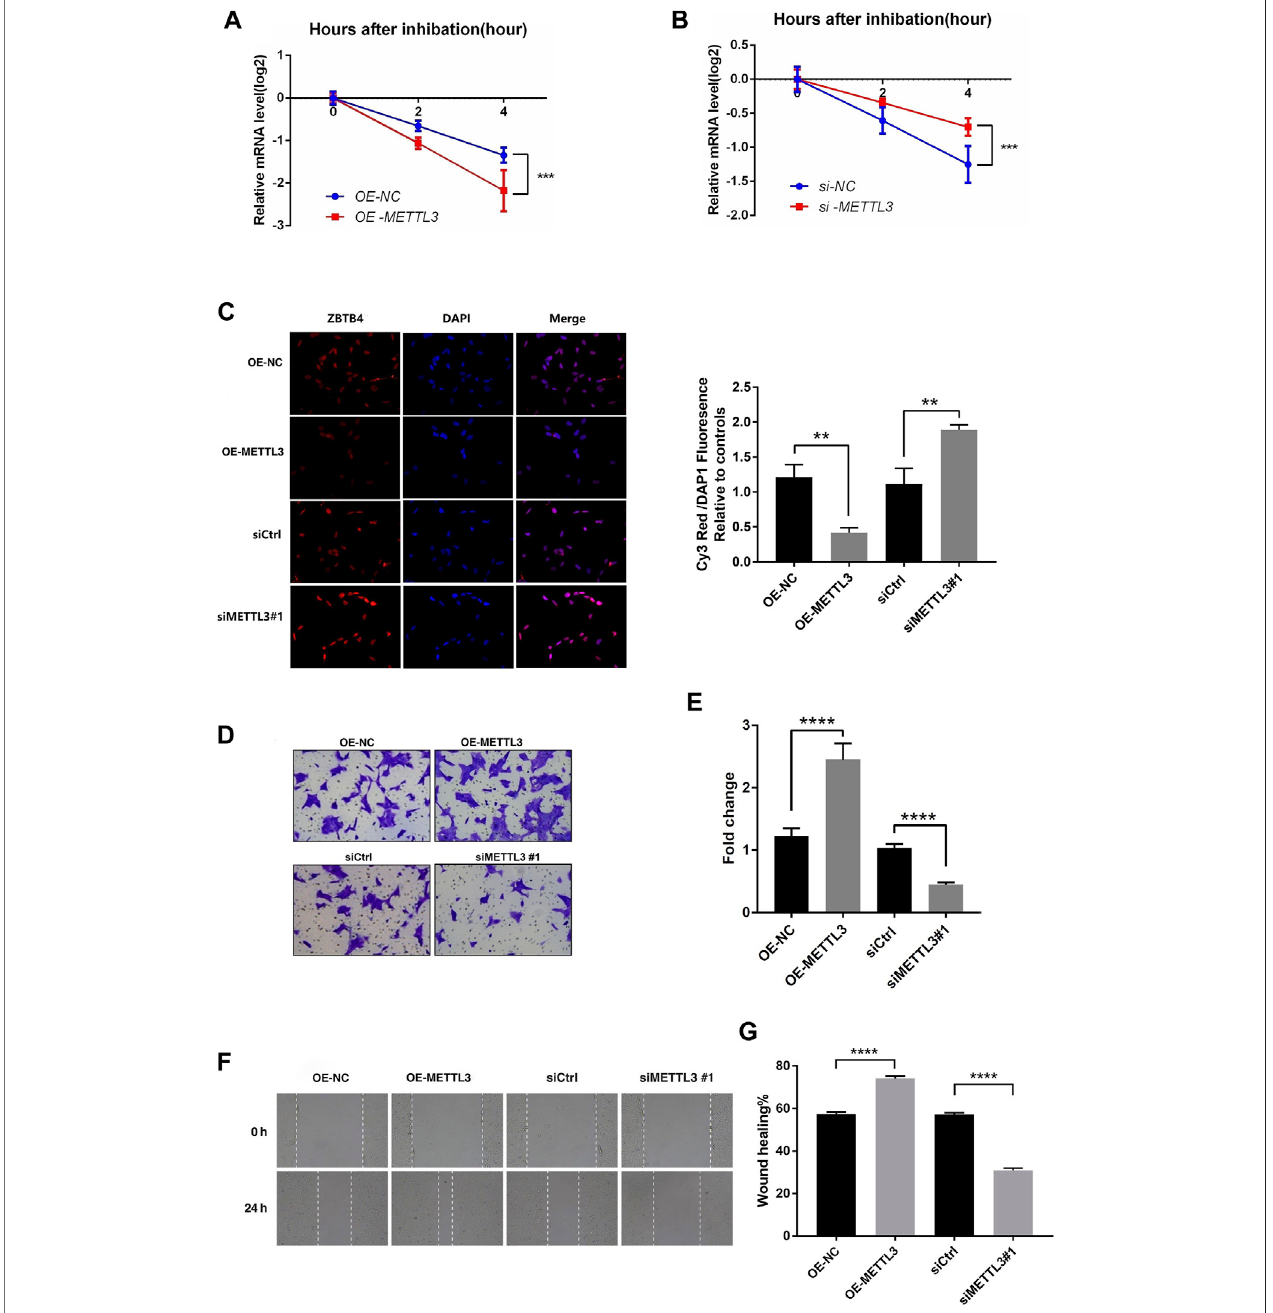
FIGURE 5 | METTL3 regulated the invasion of trophoblast by altering the stability and expression of ZBTB4. (A,B) HTR-8 cells were transfected with siCtrl, siMETTL3,vectororMETTL3-expressingplasmidfor24 h;atime courseformRNAstabilitywasinitiatedbyadding anRNA-polymeraseIIinhibitor[actinomycinD(5 μ g/ ml)].Cellswereharvestedattheindicatedtimepoints.Expressionlevelswerenormalizedtothatat “ 0 h, ” andGAPDHmRNAwasusedasthereferencegene.Theresults are shown as the mean of at least three independent experiments. * p < 0.05 versus the vector or siCtrl. (C) Results of immuno fl uorescence. Magni fi cation = ×400. (D,E) METTL3 overexpression in HTR-8 cells increased trophoblast invasion compared to that ofthe control. The invasive ability ofthe cells was assessed using Image- ProPlus6.0software.(Panel:originalmagni fi cation ×100magni fi cation). (F,G) Imagesweretakenovertimeat0and 24 h.Whitedashed linesdelineatethewoundarea. Magni fi cation =